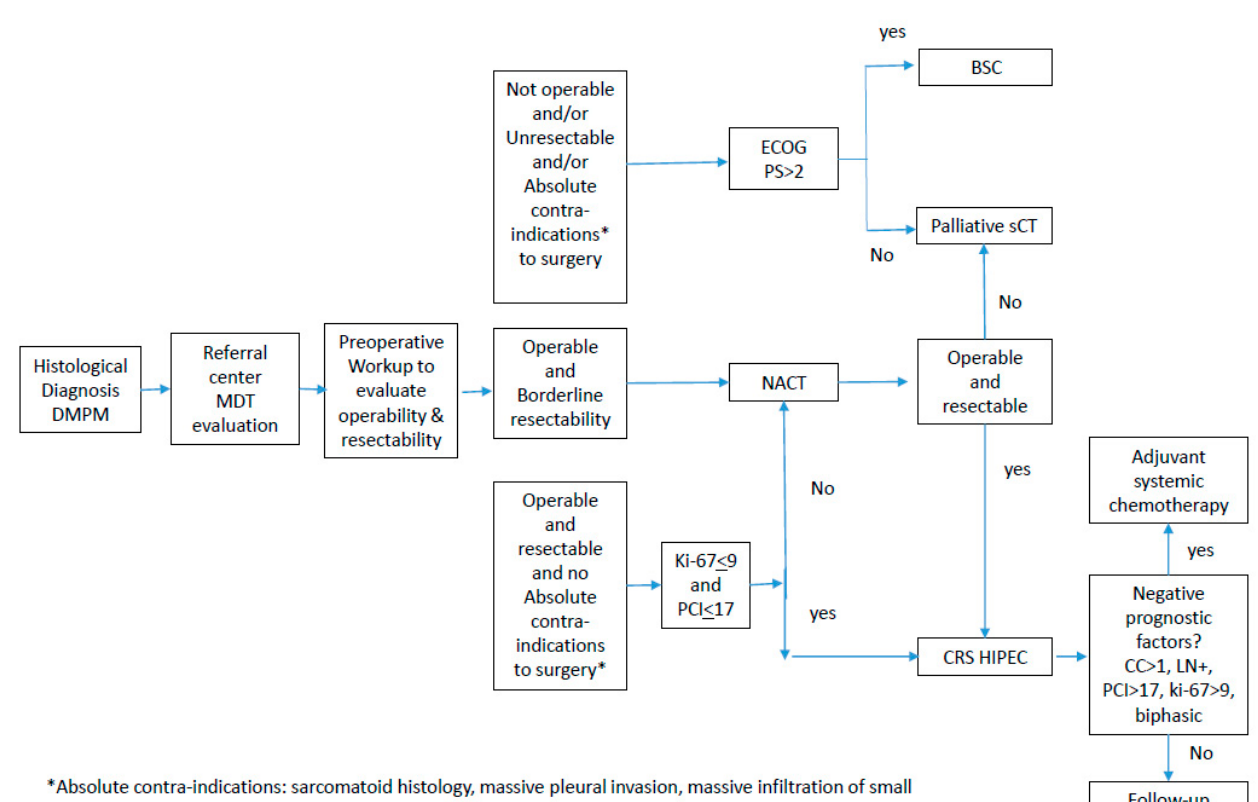
Figure 1. Diagnostic and therapeutic pathway in diffuse malignant peritoneal mesothelioma